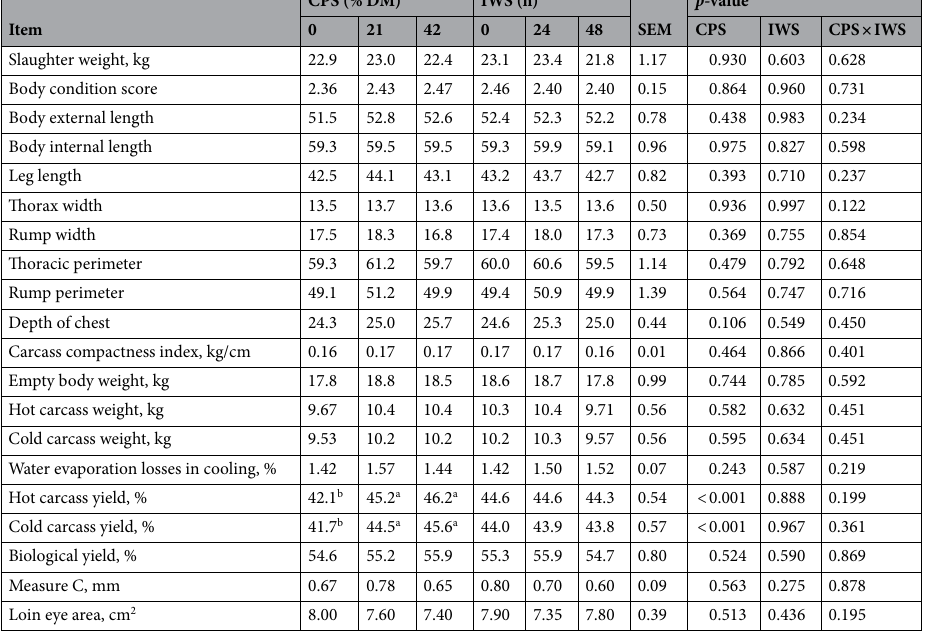
Table 1. Morphometric measurements and carcass traits of goats fed with cactus pear silage (CPS) and submitted to intermittent water supply (IWS). a,b Means within rows with different letter superscripts differ by Tukey test ( p <